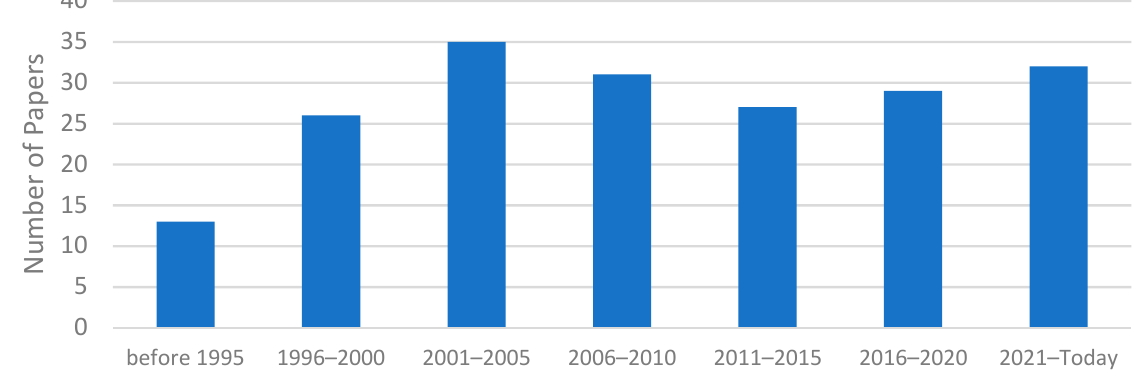
Figure 2. CMC materials research published since 1986.